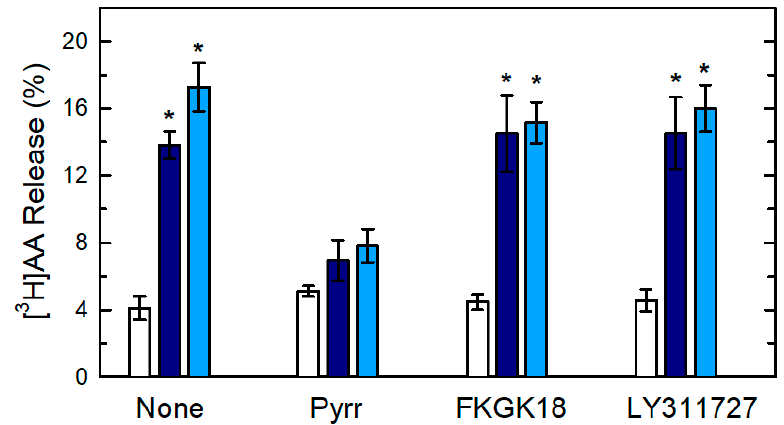
Figure 3. Effect of PLA 2 inhibitors. The [ 3 H]AA-labeled cells were untreated (none) or treated with 1 µM pyrrophenone (Pyrr), 10 µM FKGK18, and 25 µM LY311727 (see x-axis) for 30 min. Afterward they were untreated (open bars) or treated with 1 mg/mL zymosan (dark blue bars) or 1 mg/mL OpZ (light blue bars) for 1 h. Afterward, the extracellular media were removed and analyzed for 3 H-radioactivity content. The data are expressed as mean values ± S.E.M. ( n = 6). * p < 0.05, significance of OpZ- or zymosan-treated cells versus untreated cells at the indicated conditions.